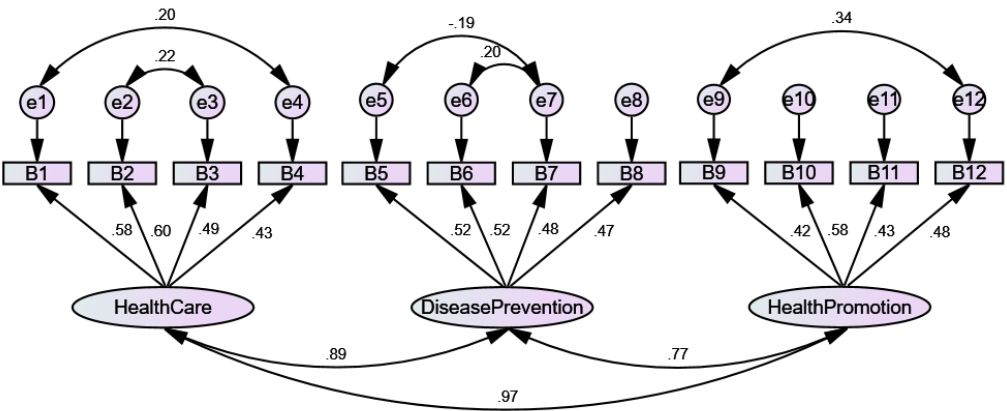
Figure 1. Structure equation model of the HLS-SF12 with 12 items loading into three domains of health (health care, disease prevention, health promotion).